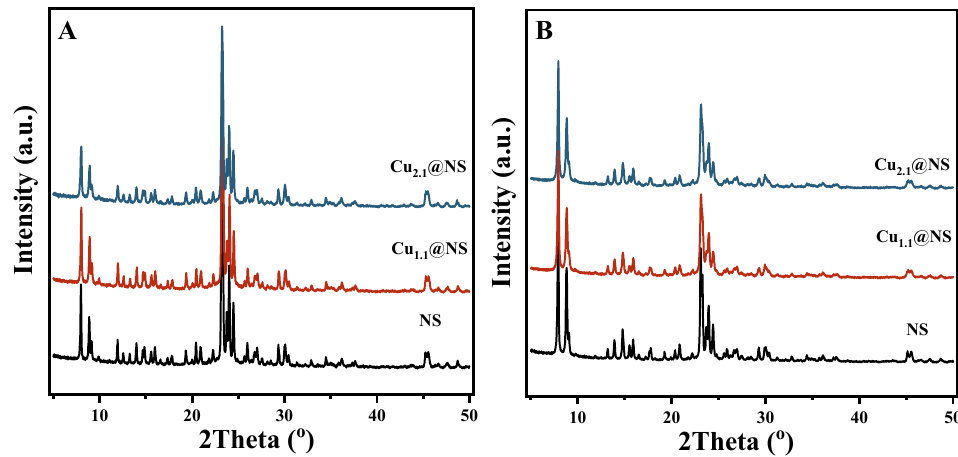
Figure 1. Powder XRD of as-synthesized ( A ) and calcined ( B ) nanospheres of silicalite-1 (NS) and Cu-loaded silicalite-1 (Cu@NS); the numbers in the materials’ names indicate the loading amounts of Cu atoms in weight percentages.